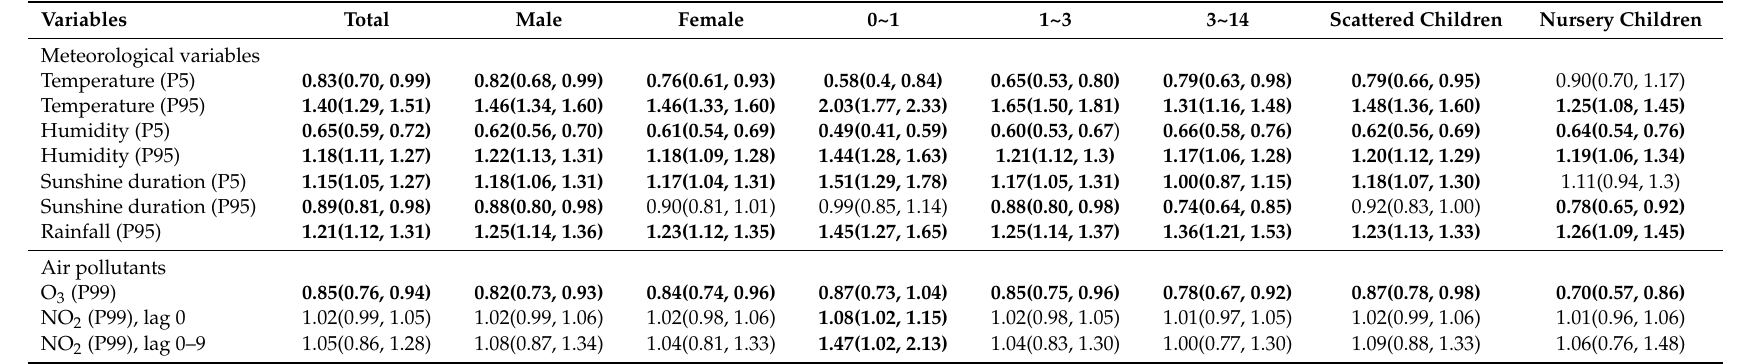
Table 2. Cumulative e ff ects of meteorological variables and air pollutants on HFMD occurrence over 14 days (except for NO 2 ) in total cases and di ff erent subgroups, estimated by cumulative relative risk (cRR) and 95% CI in Shenzhen,